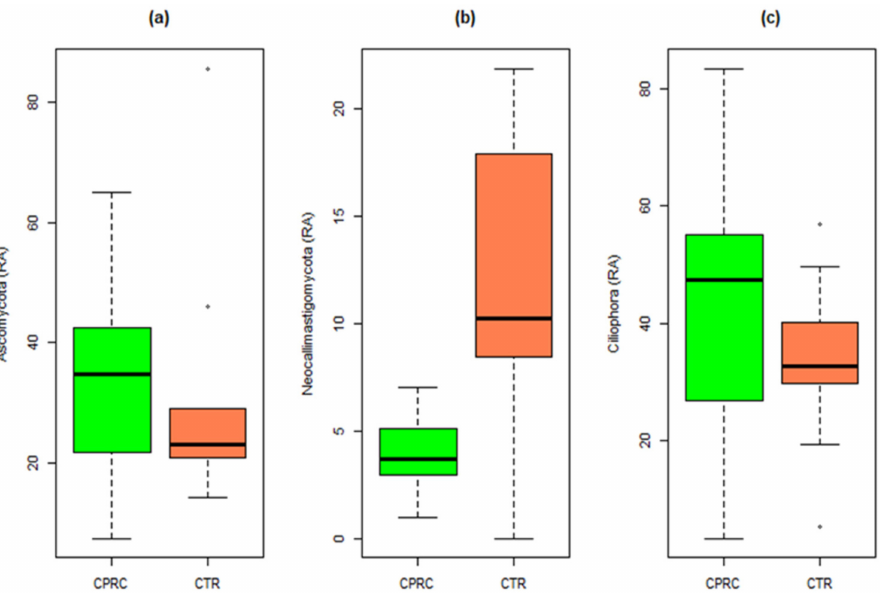
Figure 4. Relative abundances of the three main Eukaryote phyla in rumen samples of cows fed a concentrate with cold-pressed rapeseed cake (CPRC) or a control concentrate (CTR). ( a ) Relative abun- dance of Ascomycota, ( b ) relative abundance of Neocallimastigomycota, and ( c ) relative abundances of